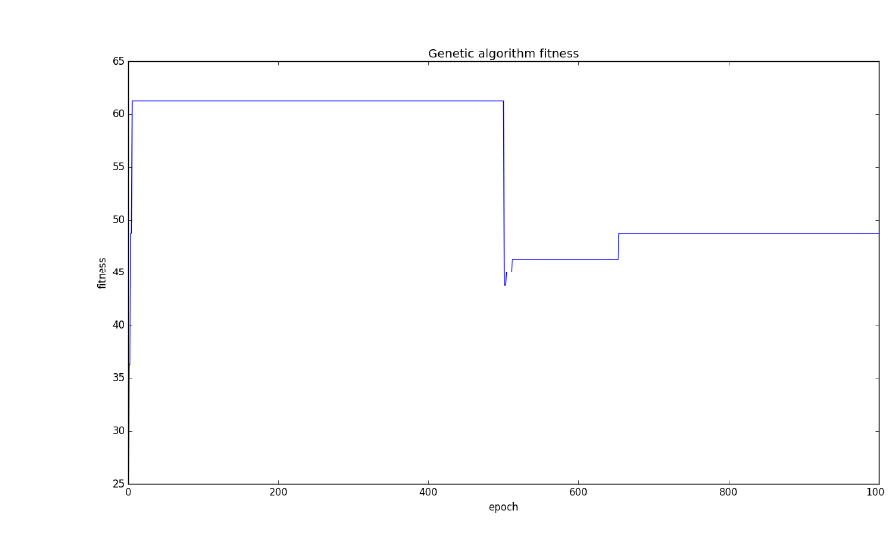
Fig. 2. Evolutionary algorithm fitness function value after switching task and changing mutation rate in adaptive